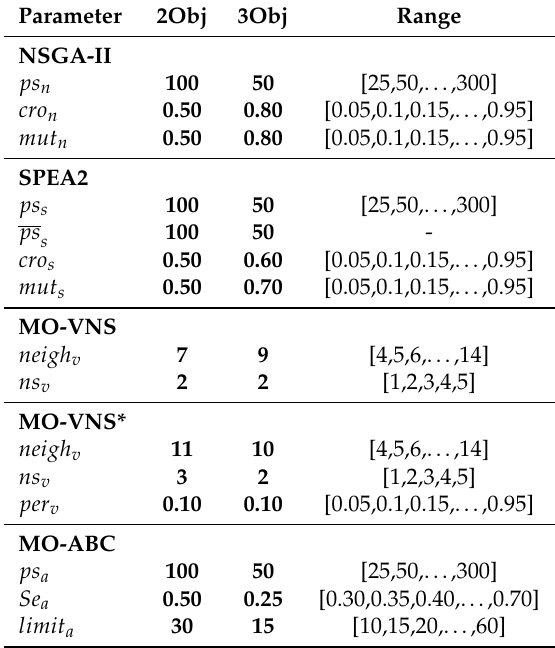
Table 2. Parameter